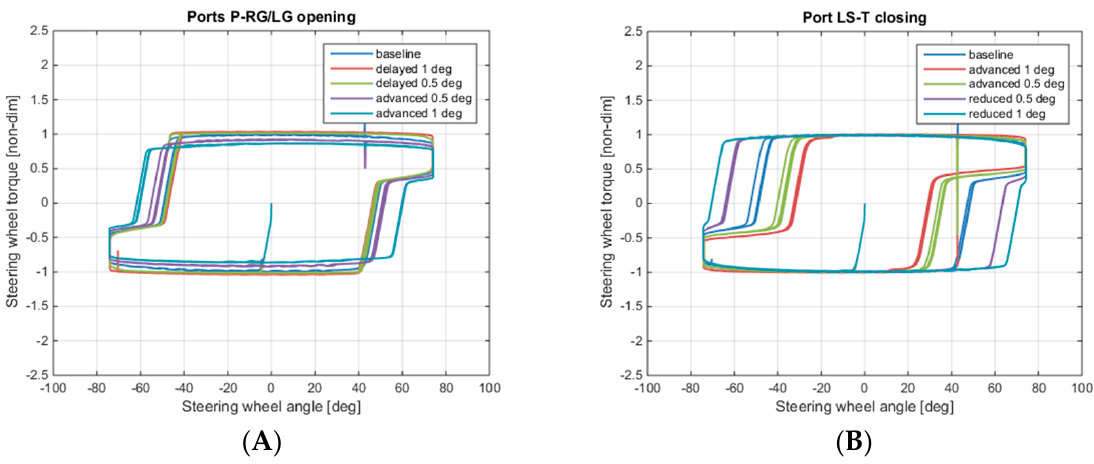
Figure 18. ( A ) Steering wheel torque-angle curve obtained translating the flow areas P-RG and P-LG; ( B ) Steering wheel torque-angle curve obtained modifying the flow area LS-T.